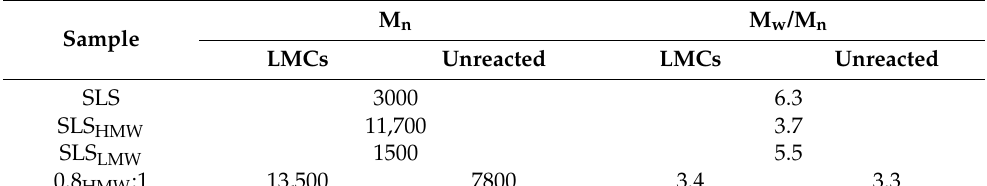
Table 2. Number average molecular weight distribution (M n ) and polydispersity index (PDI) of pristine and fractionated SLS and of capsule-forming and unreacted SLS for the 0.8 HMW :1 sample.